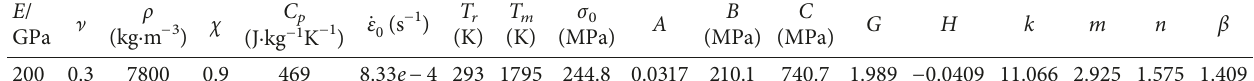
Table 2: Material parameters of Q235B steel.